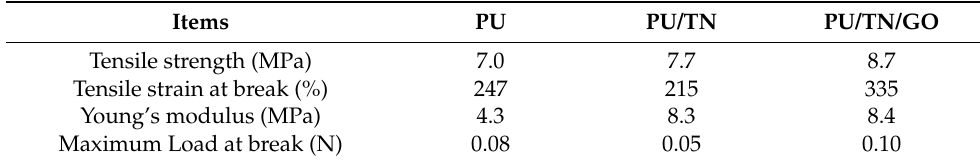
Table 1. Mechanical properties of PU and its nanocomposite fibers. Items